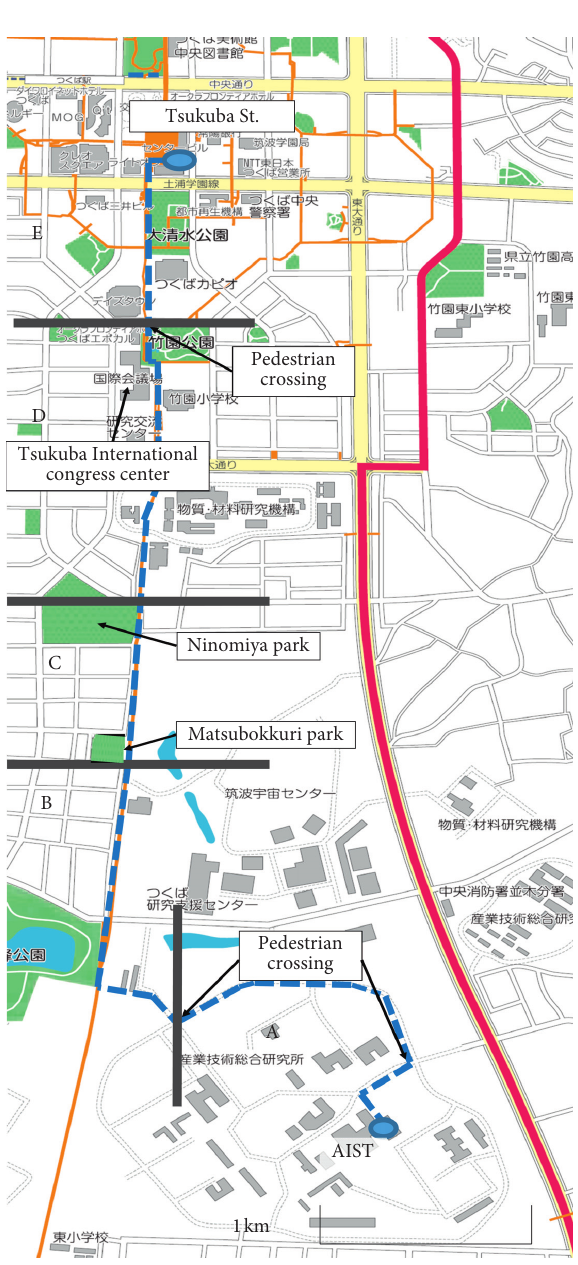
Figure 2: Experimental route for Scenario 1 (dashed blue line: route; blue circles: start and end points; gray lines: borders between each of the five